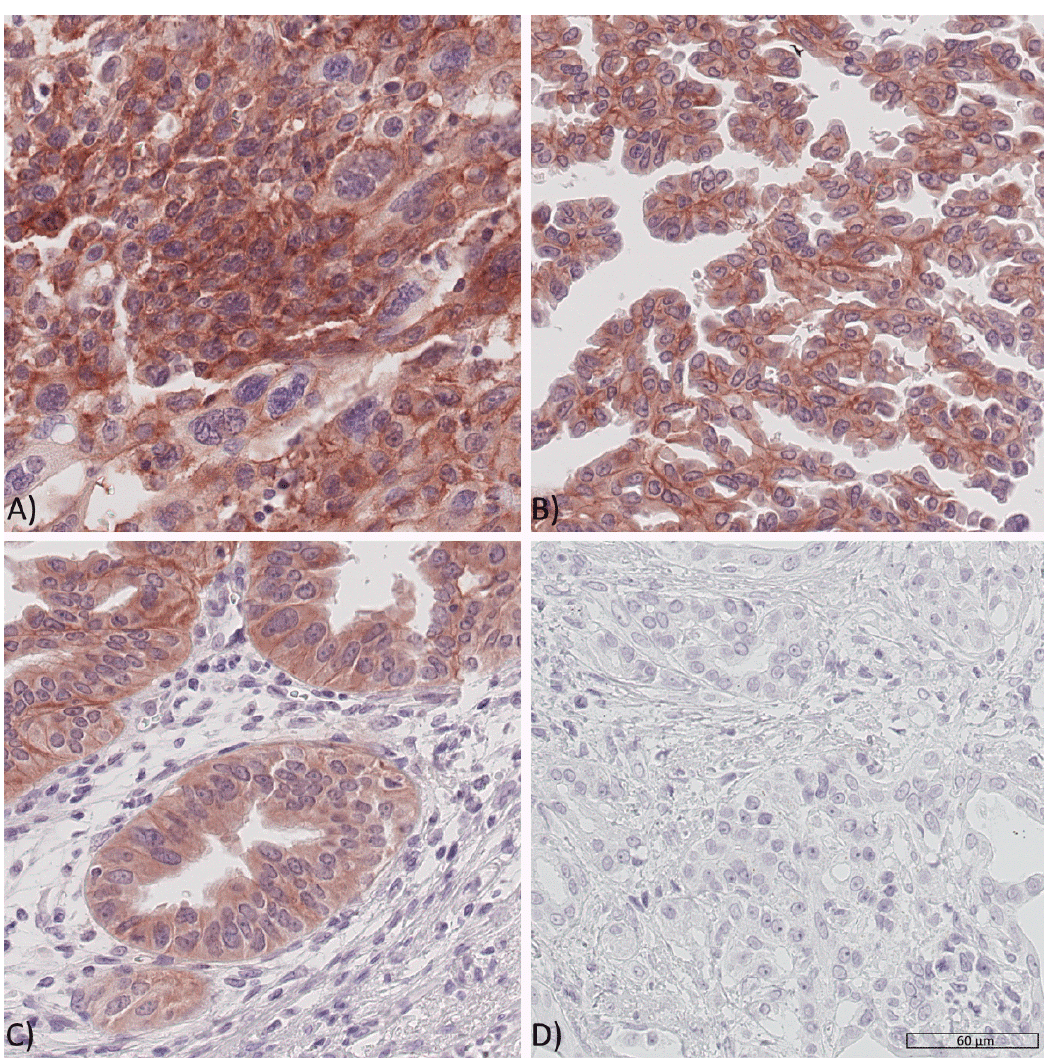
Figure 2. Expression of the IGF1 receptor in PDAC tissues. Representative PDAC tissue samples showing ( A ) high cytoplasmic (c-IGF1R 2+), high membranous (m-IGF1R 2+) IGF1 receptor expression in tumor cells, ( B ) weak cytoplasmic (c-IGF1R 1+) and weak as well as high membranous (mIGF1R 1+ and 2+) IGF1 receptor expression, ( C ) showing weak cytoplasmic (c-IGF1R 1+) and occasionally high membranous (upper left corner, m-IGF1R 2+) IGF1 receptor expression and ( D ) no sign of IGF1 receptor expression (IGF1R 0). Original magnification A-D: 400×.